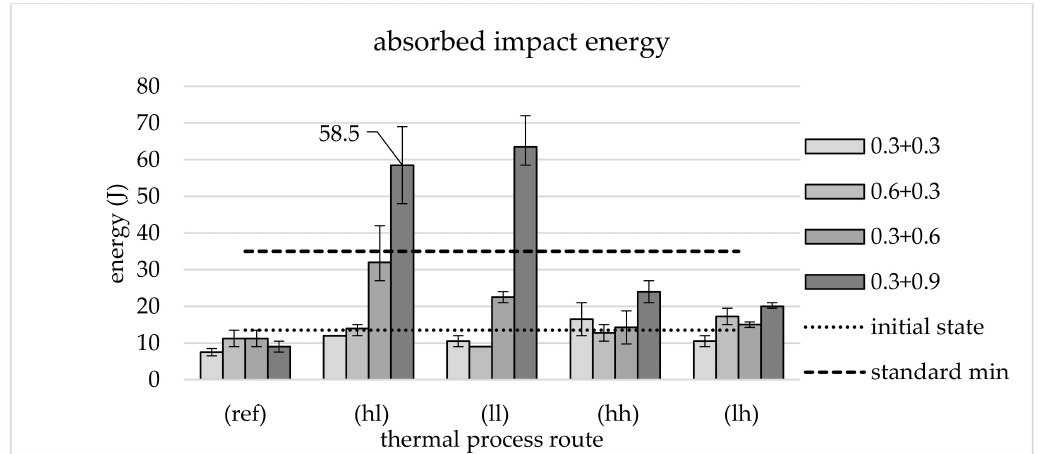
Figure 9. Absorbed impact energy: Initial state, reference, di ff erent TMT routes and requirement of the standard, average of three tests and range of